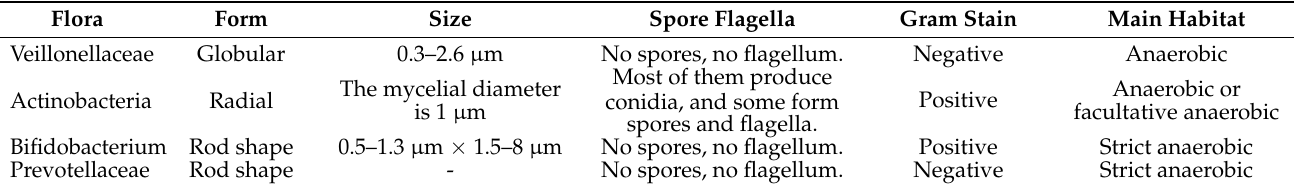
Table 8. Morphological characterization of differential flora.